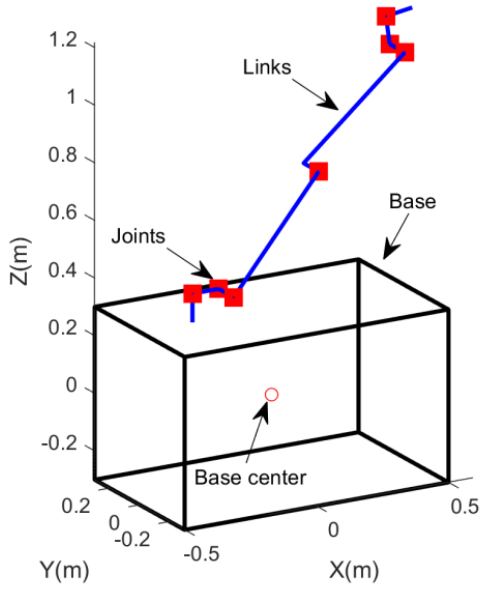
Figure 10. Initial contact configuration of free-floating space robot.